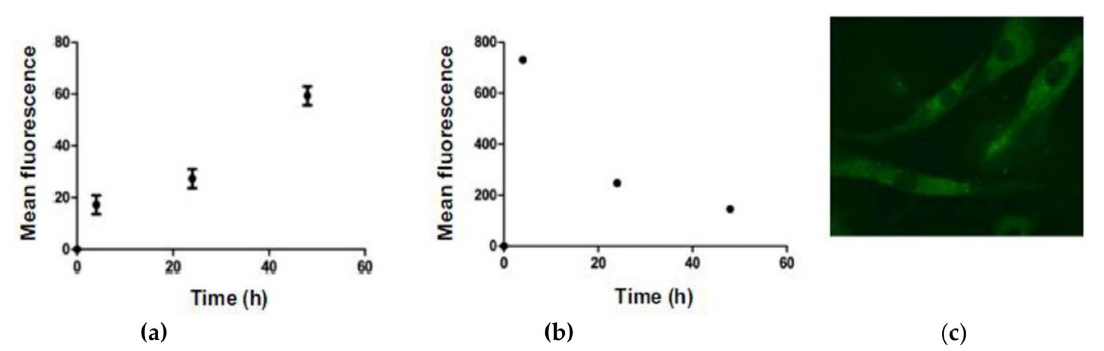
Figure 11. Flow cytometric analysis of human fibroblasts cells incubated for 4, 24, or 48 h with 20 µ M BODIPY-labeled vitamin B 12 ( a ) or free BODIPY ( b ). Fluorescence microscopy images of human fibroblasts cells incubated 24 h with free BODIPY ( c ). Adapted from